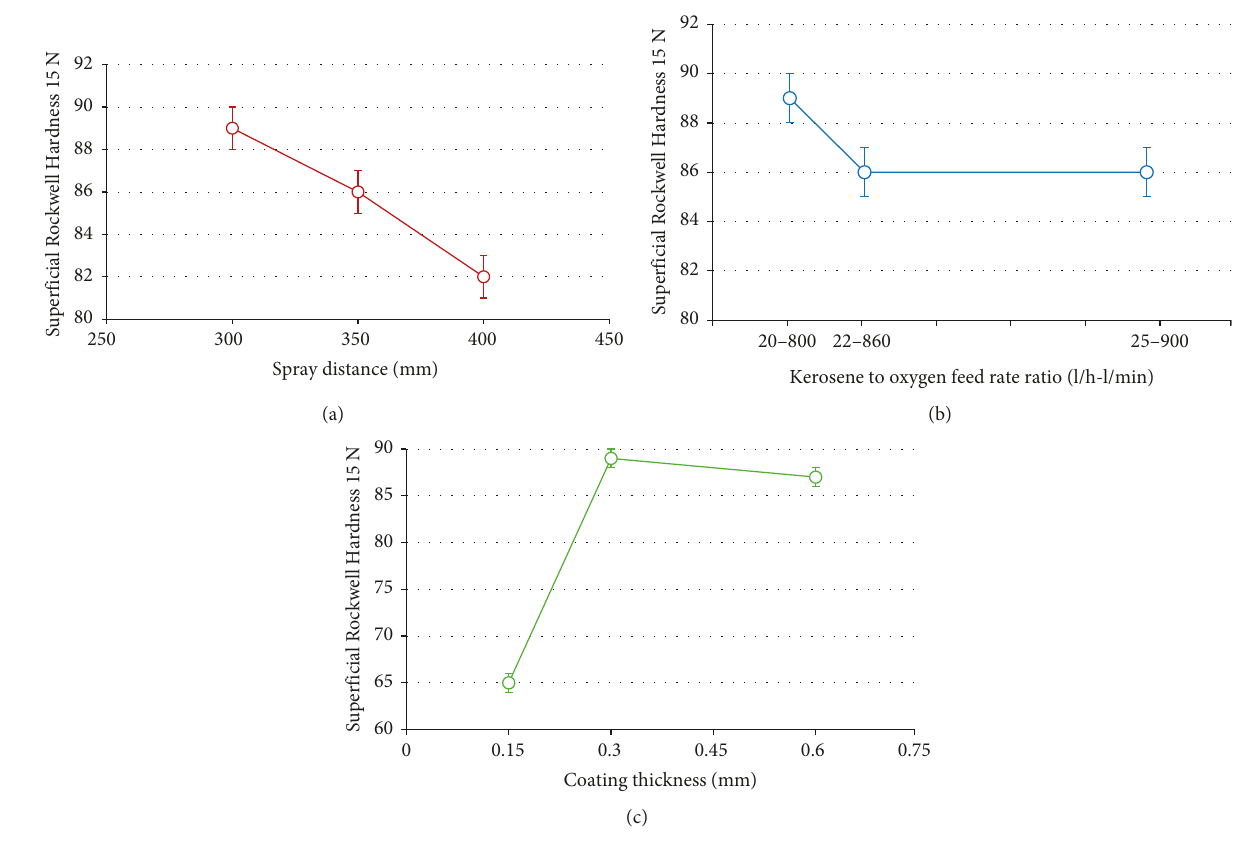
Figure 1: Effect of (a) spray distance, (b) kerosene to oxygen feed rate ratio, and (c) coating thickness on coating